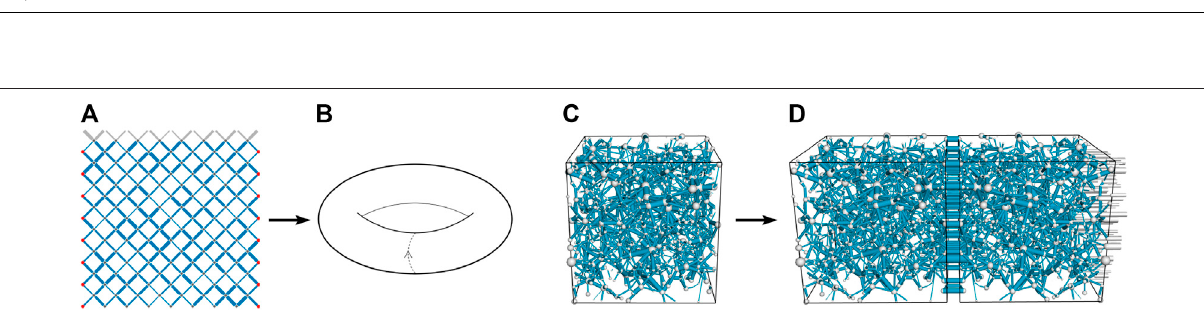
FIGURE 7 | We show the effect of changing the maximum number of menisci ( N max ) with the merging scheme C , the merge_cmnn. The steady-state non-wetting fractional fl owisplottedasafunctionofnon-wettingsaturationfor N max =2,3,4and5.Withsuchachangeinthemeniscuscount,nonoticeabledifferenceisobservedin the qualitative behavior in F n .